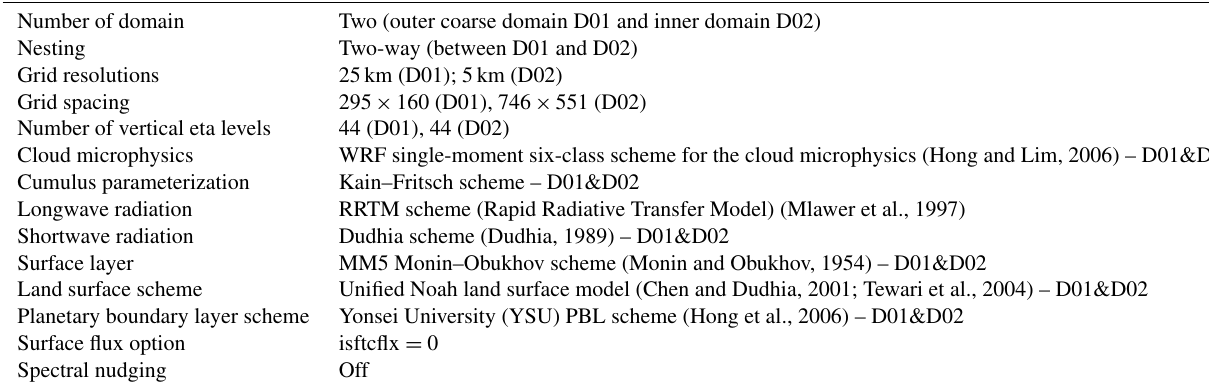
Table 3. WRF configuration for the control experiment (KFsnOFFsf0). Number of domain Two (outer coarse domain D01 and inner domain D02) Nesting Two-way (between D01 and